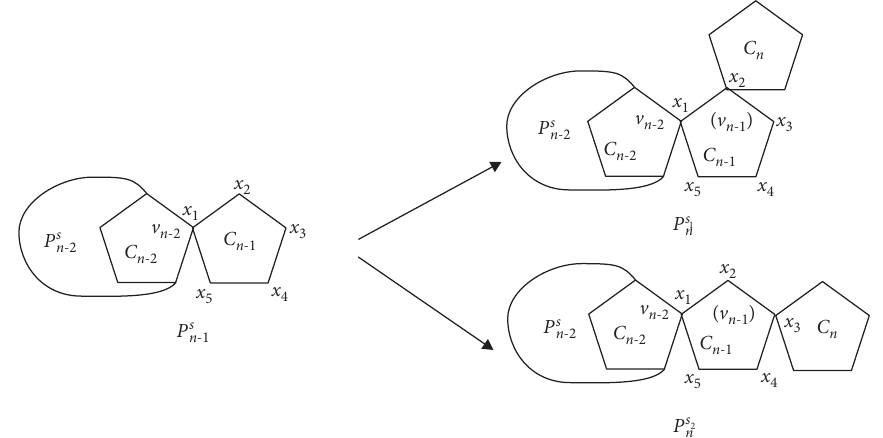
Figure 6: Two types of local arrangements in a